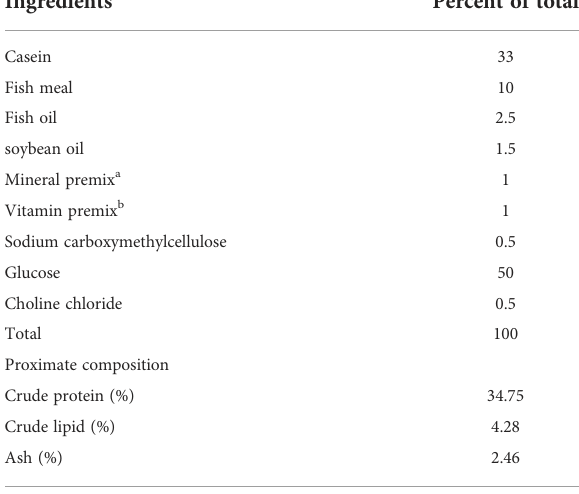
TABLE 1 Ingredients and proximate composition (% dry matter) of experimental